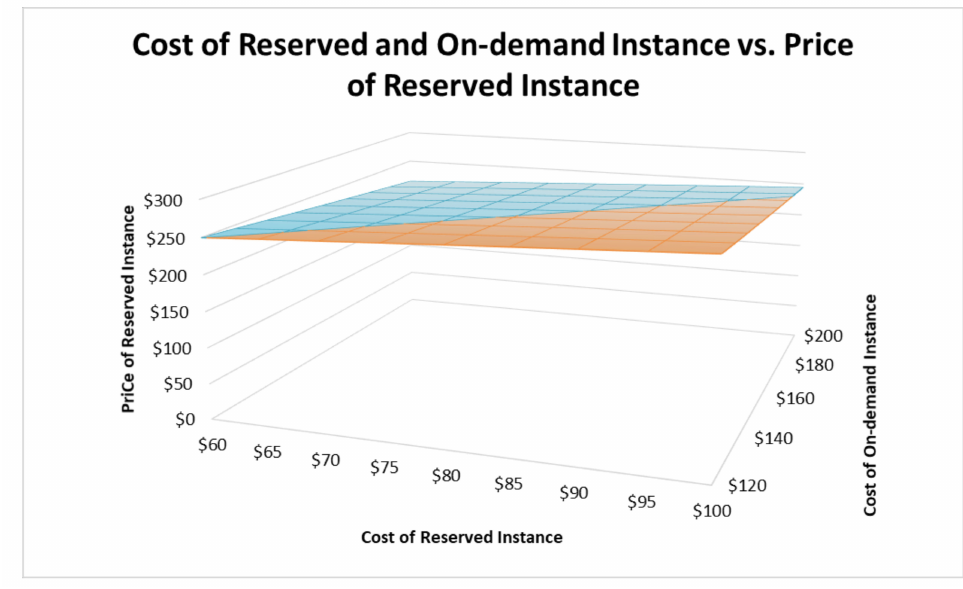
Figure 5. Costs of Reserved Instance and On-demand Instance vs. Price of Reserved Instance.